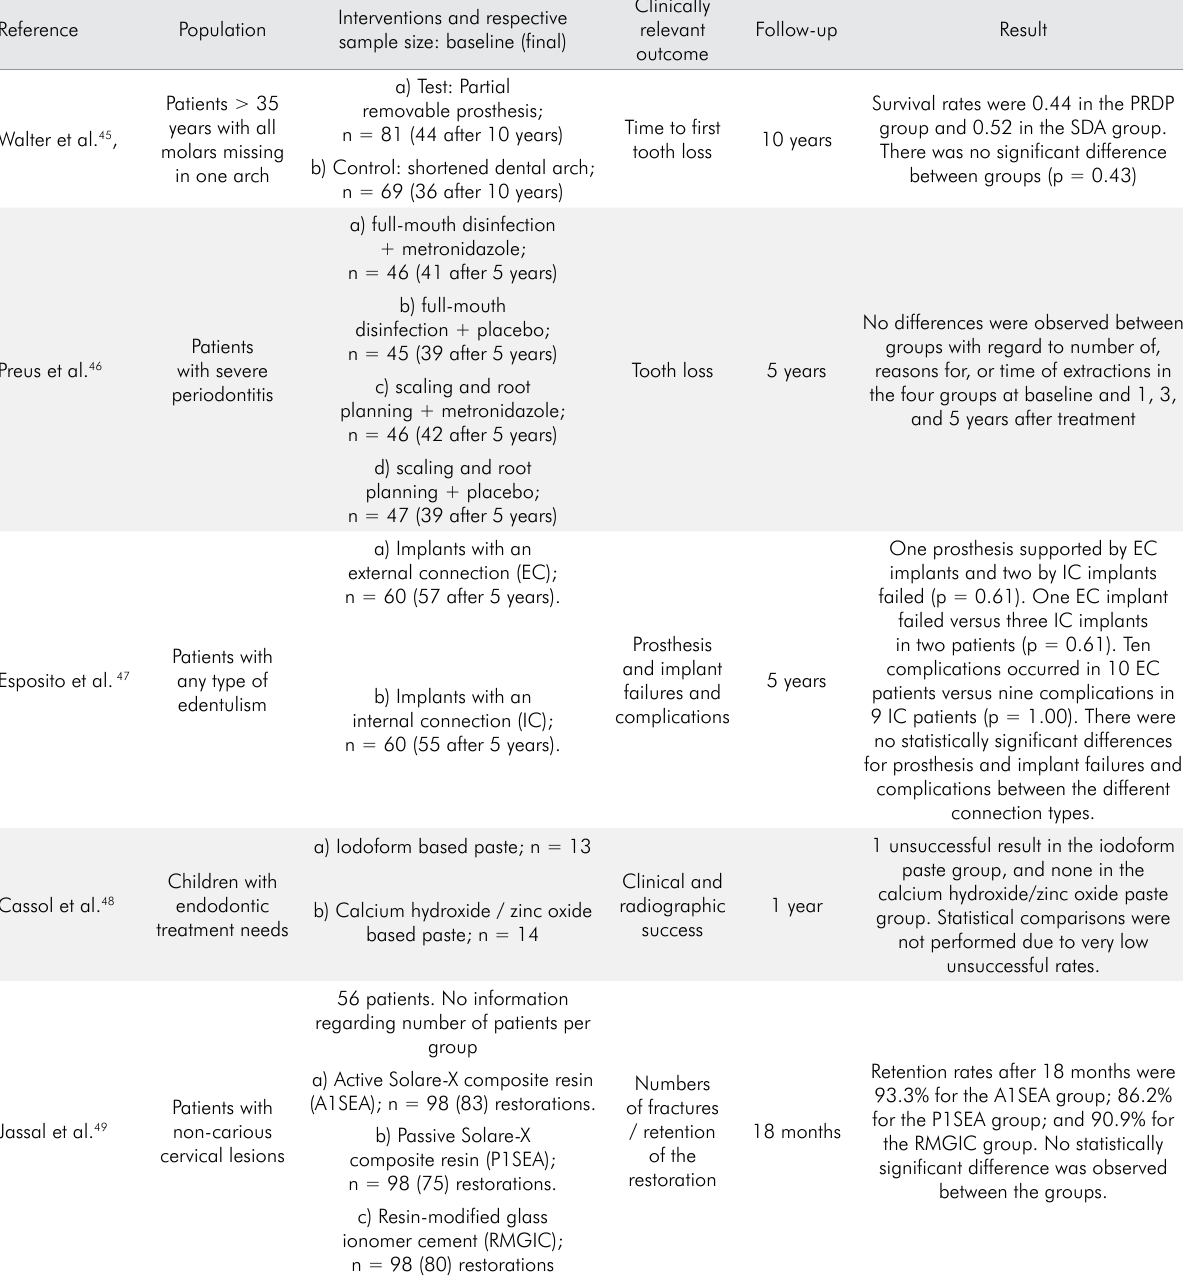
Table 2. Examples of randomized controlled trials in Dentistry that used objective clinically relevant outcomes but failed in showing statistically significant differences among the